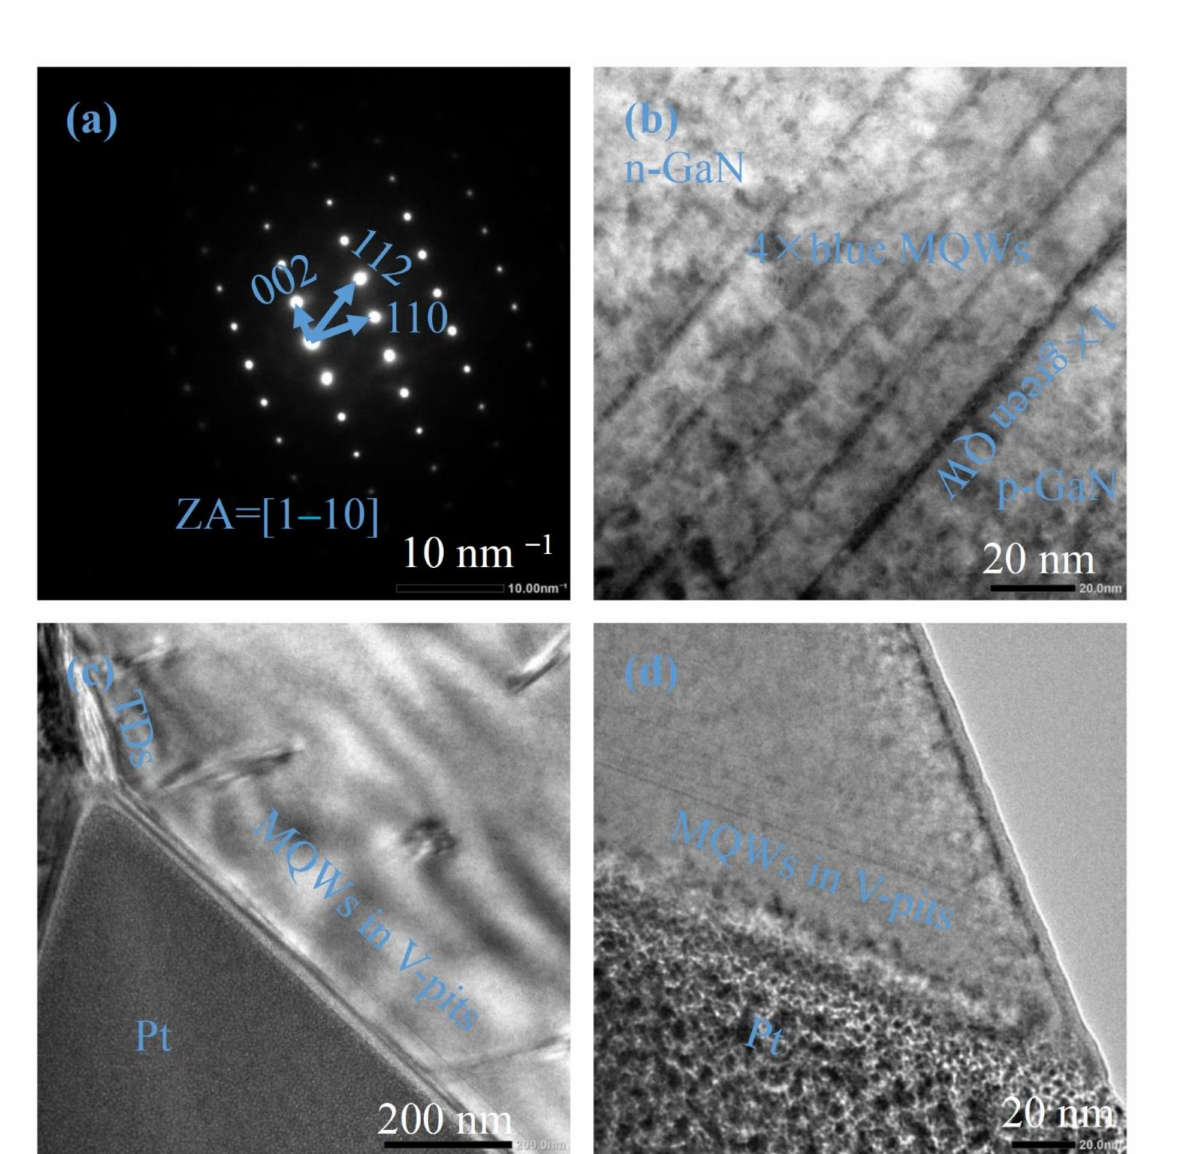
Figure 2. ( a ) The SADPs of the LED. ( b ) The MQWs of the LED. ( c ) The MQWs grown on the sidewall of a V-pit. ( d ) The enlarged image of the MQWs grown on the sidewall of a